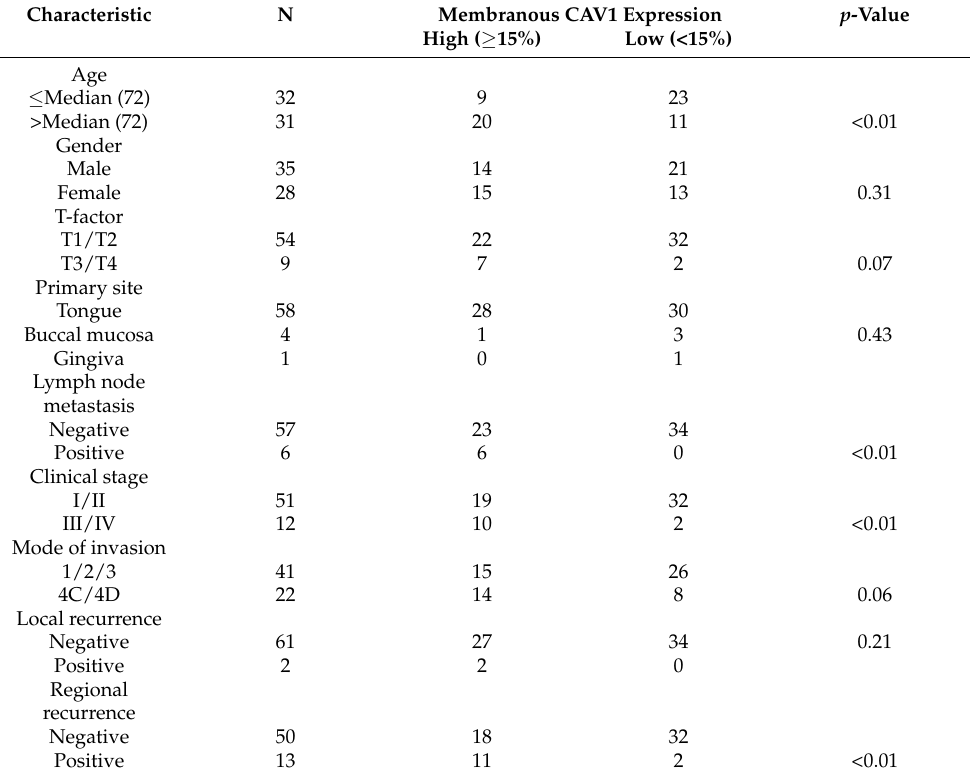
Table 1. Relationship of clinicopathological factors of the OSCC cases with membranous CAV1 expression.